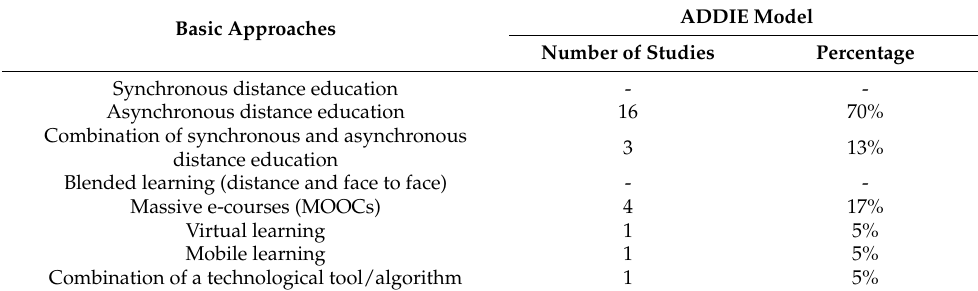
Table 3. Basic approaches from the application of the model in distance education.